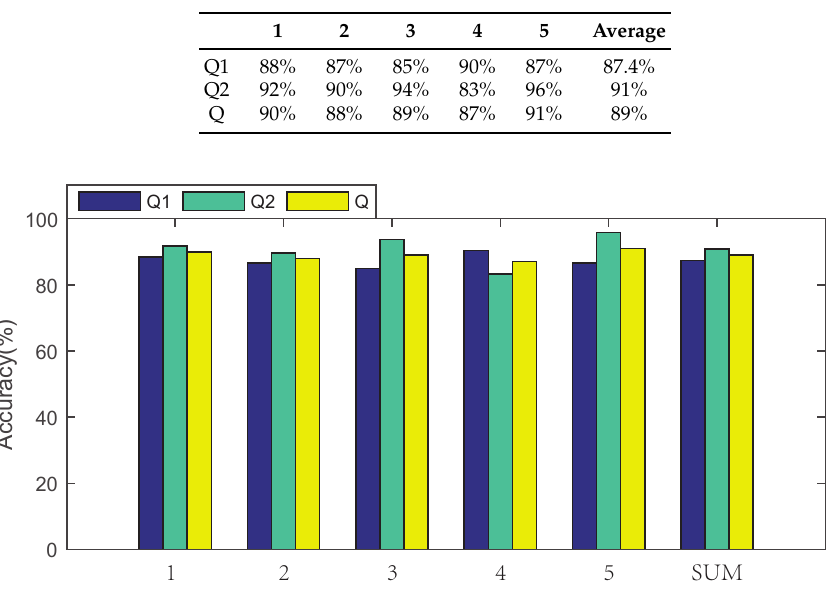
Figure 13. Accuracy of Q1, Q2,